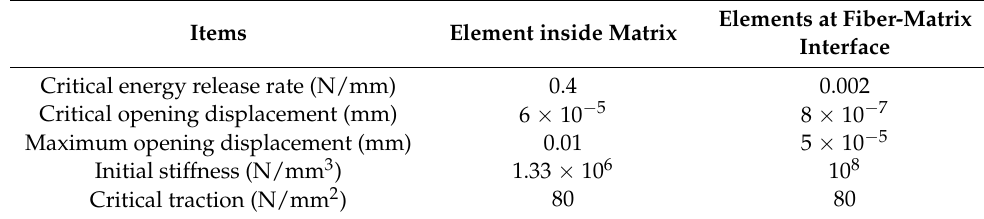
Table 4. Constants of cohesive elements inserted at different locations.